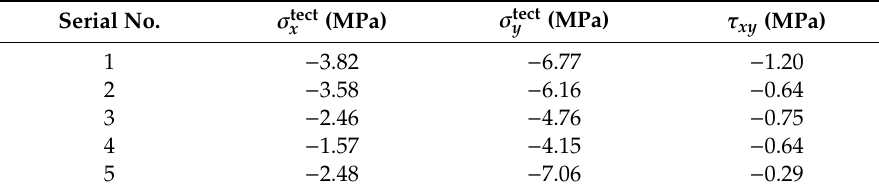
Table 4. The tectonic stresses after removing gravitational and thermal